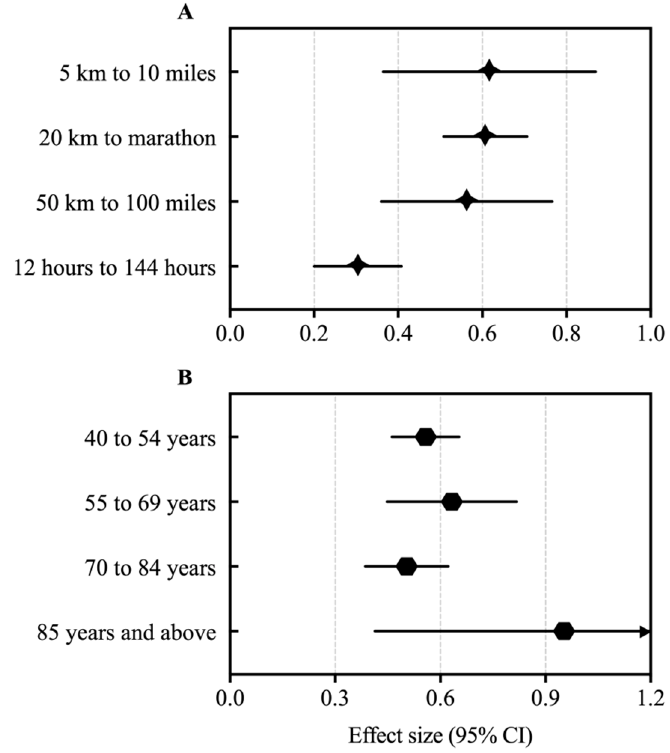
Figure 1. Performance gap between men and women in American masters road